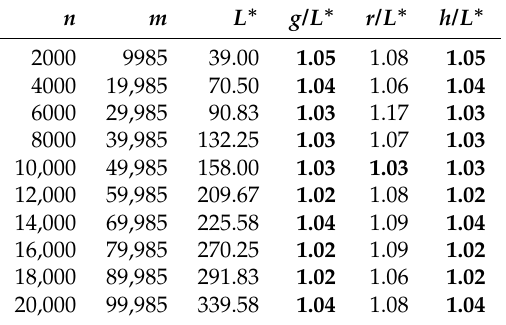
Table 3. Results for 5-Trees.